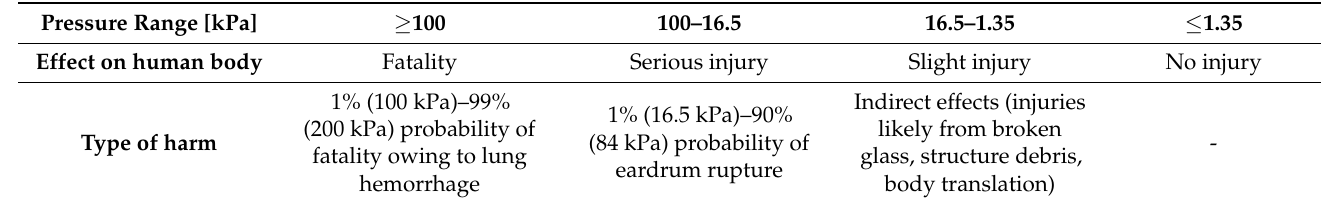
Table 4. Limit distances according to the effects of pressure on the human body.